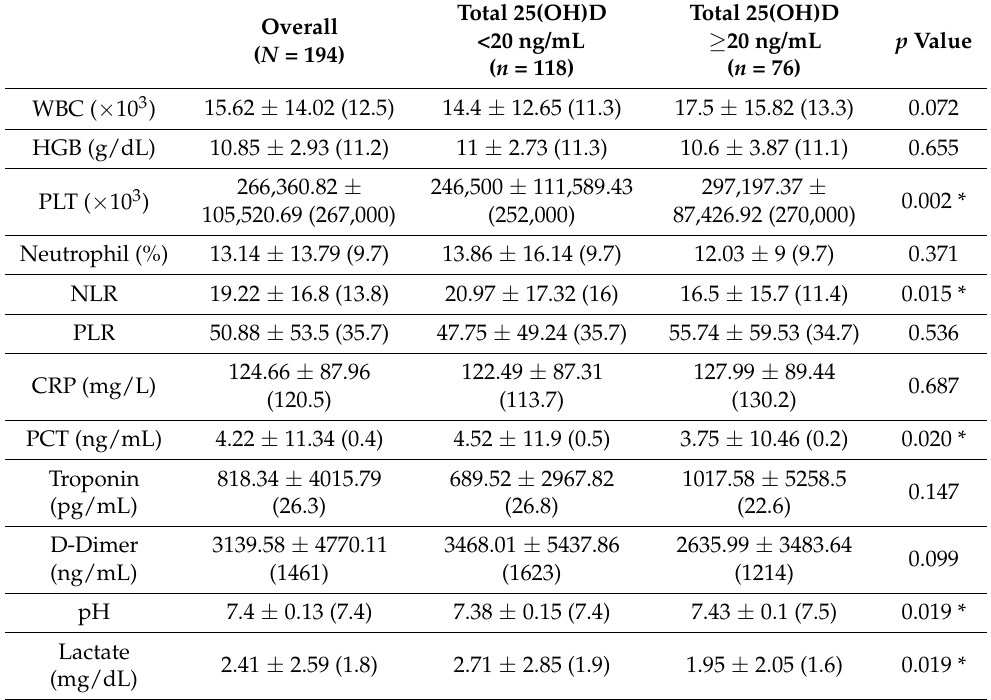
Table 3. The laboratory findings of COVID-19 patients at the admission to ICU compared according to the vitamin D